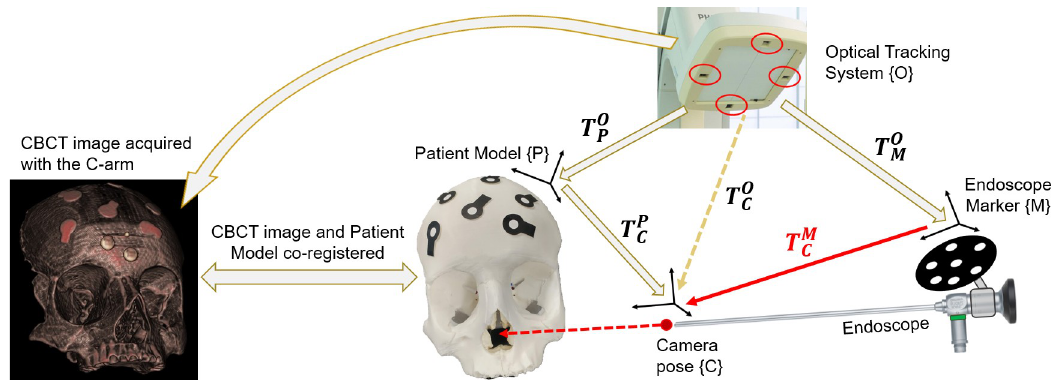
Fig 3. Hand-eye calibration with a moving calibration plate.